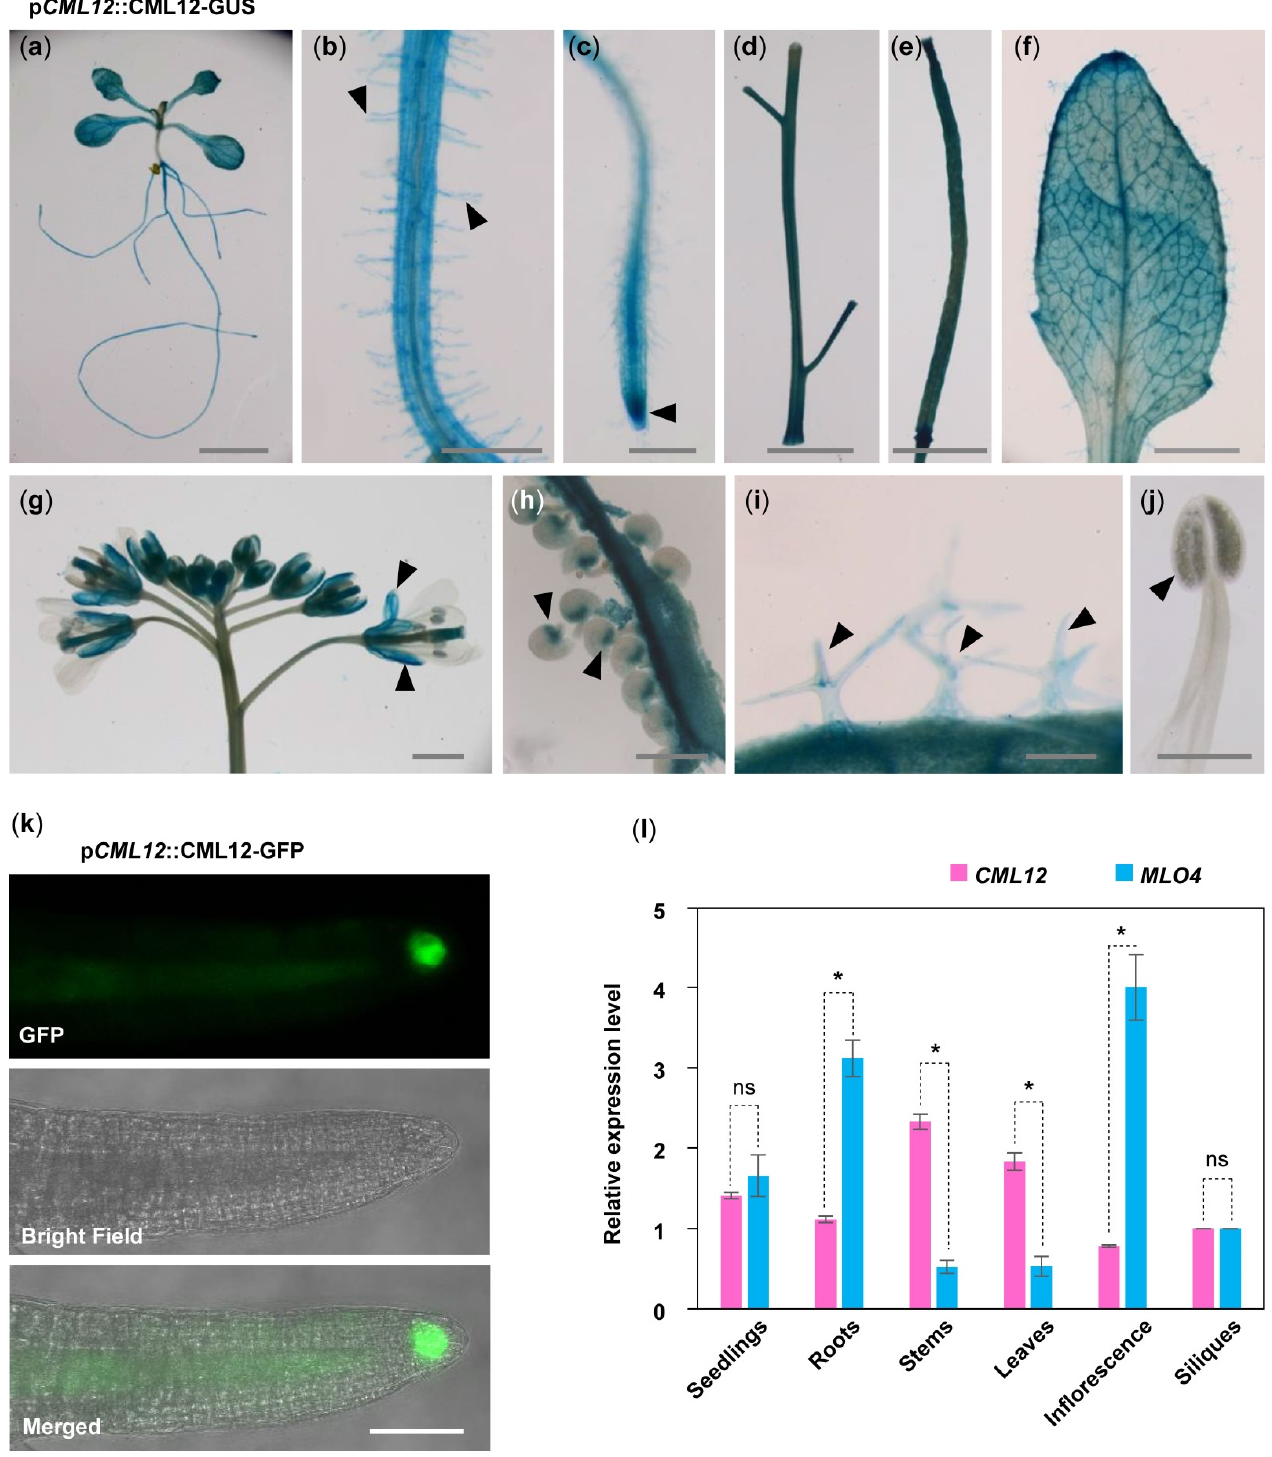
Figure 3. Expression pattern of CML12 Gene. GUS staining of p CML12 ::CML12-GUS transgenetic lines showed CML12 was expressed in most of the vegetable tissues: Seedling ( a ), root hairs ( b ), root tip ( c ), stems ( d ), silique ( e ), leaf ( f ), sepals ( g ), chalazal end of ovules ( h ), and trichomes ( i ), not in pollen ( j ), as indicated by pointed triangles in each figure. Bars = 100 µ m. ( k ) p CML12 ::CML12-GFP transgenetic lines showed CML12-GFP was detected in root cap. Bar = 20 μ m. ( l ) Real- time PCR showed that CML12 and MLO4 genes both were expressed in various tissues of Arabidopsis . ns: not significant; the * above bars indicate the t -test results at significant level of 0.05.